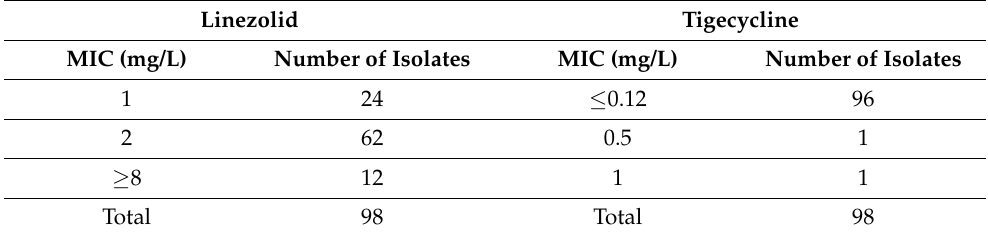
Table 12. Minimum inhibitory concentrations (MICs) for Linezolid and